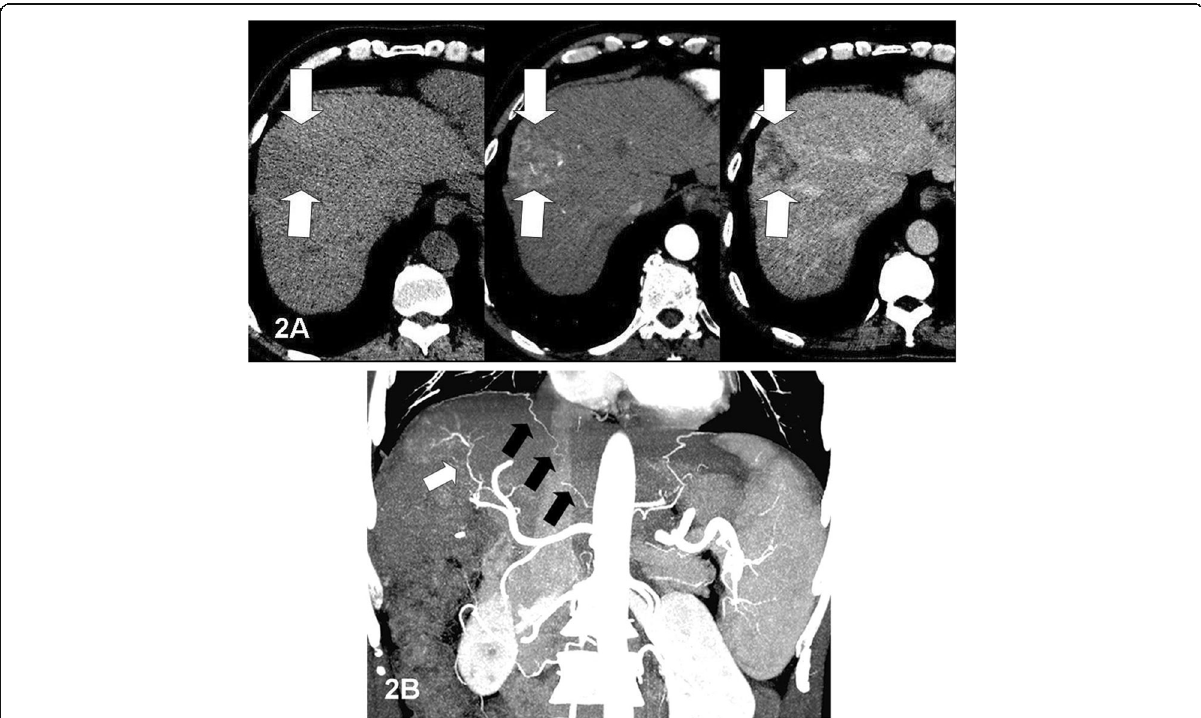
Fig. 2 Initial multi-phase CT liver with a axial non-contrast, arterial and delayed phases showing HCC (white arrows) at segment VIII with wash-in wash-out contrast dynamics. b Coronal MIP showing double arterial supply of the lesion by the right hepatic artery (white arrow) and by extra- hepatic right inferior phrenic artery (black arrows)